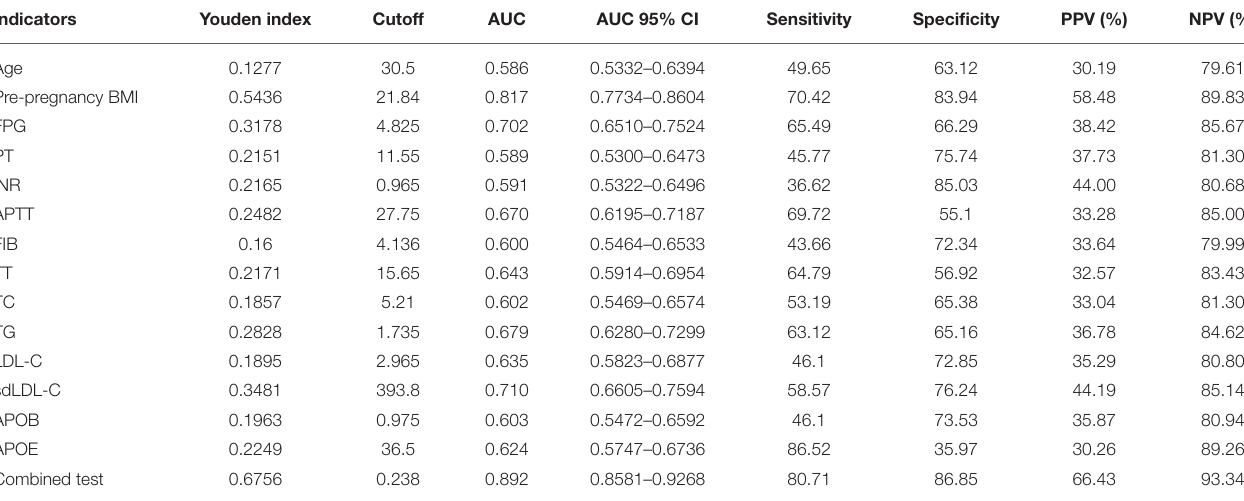
TABLE 5 | Diagnostic performance of laboratory-related indicators in pregnant women with GDM. Indicators